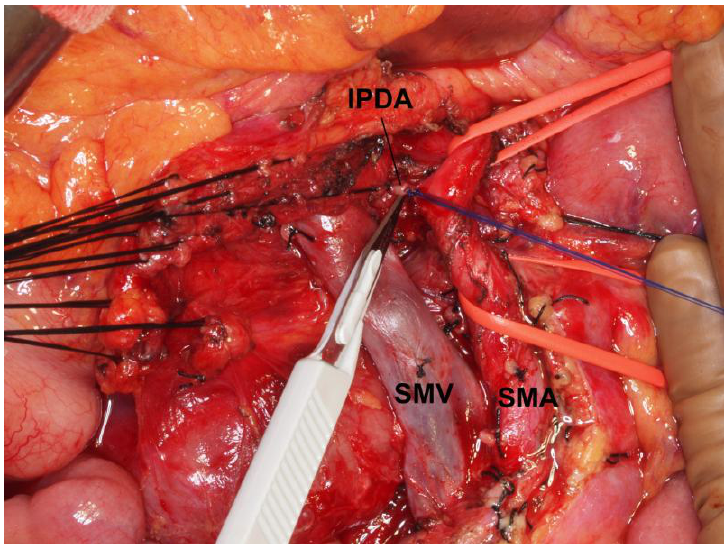
Figure 1. Photograph of lymph node dissection around the superior mesenteric vein and artery, by the mesenteric approach. The inferior pancreatoduodenal artery is exposed, ligated and divided. SMA, superior mesenteric artery; SMV, superior mesenteric vein; IPDA, inferior pancreatoduodenal